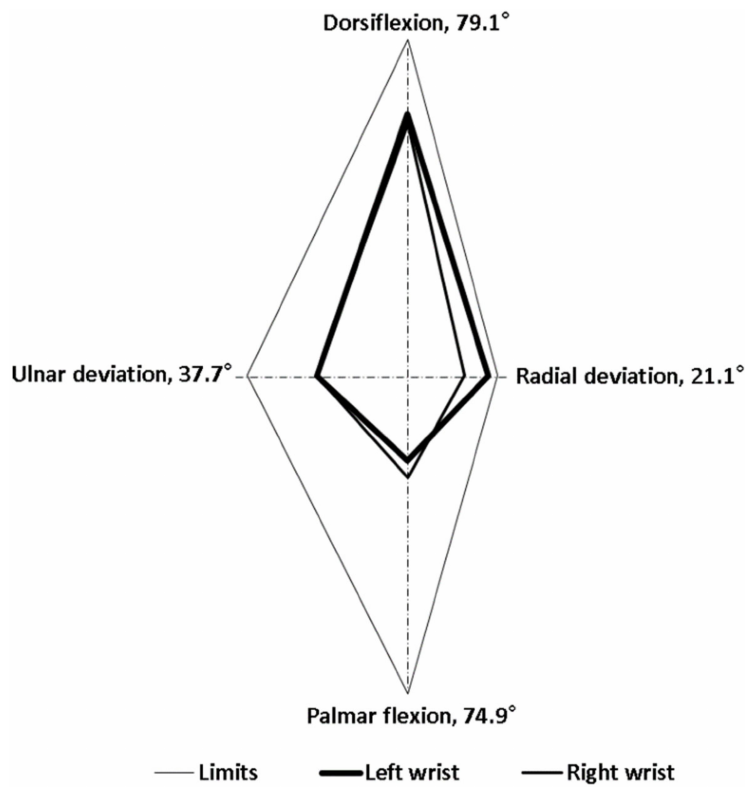
Figure 5. Maximum movement range of the wrist joint during the dough rod operation.